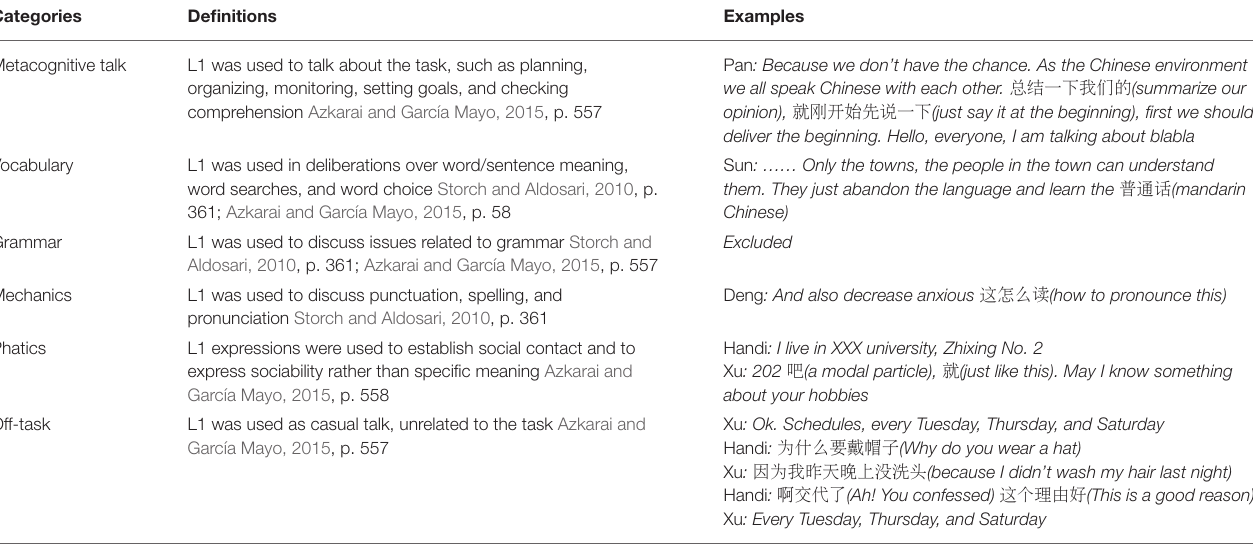
TABLE 3 | A working list of L1 functions.